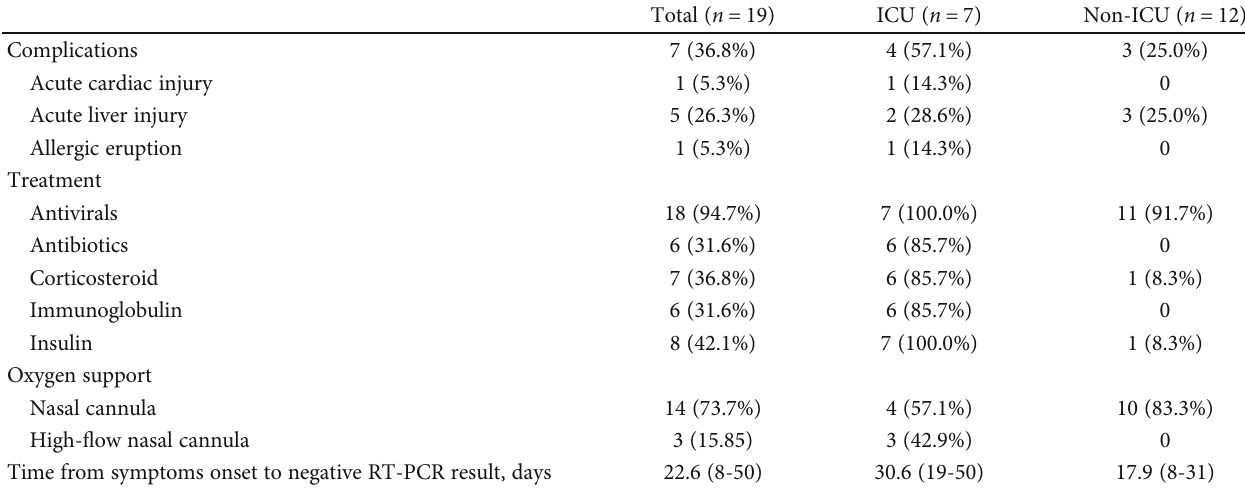
Table 3: Treatment and outcomes of DM patients with